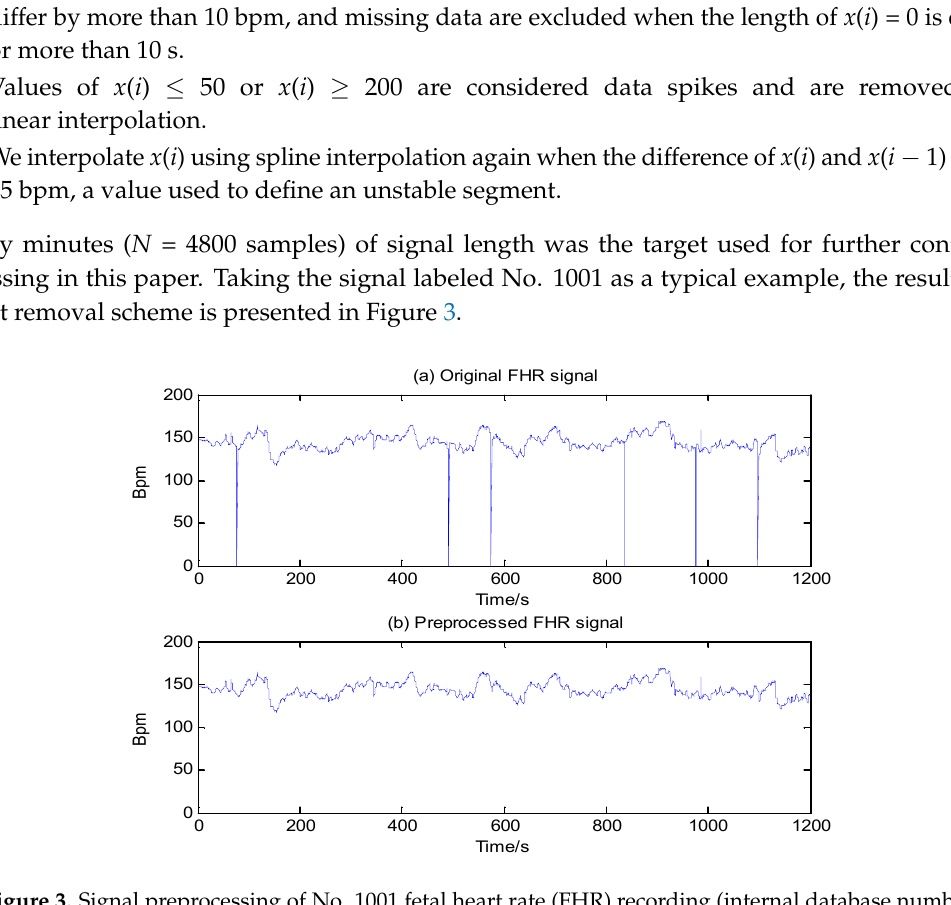
Figure 3. Signal preprocessing of No. 1001 fetal heart rate (FHR) recording (internal database number). ( a ) Original FHR signal; ( b ) Denoised FHR signal. ( a ) Original FHR signal; ( b ) Denoised FHR